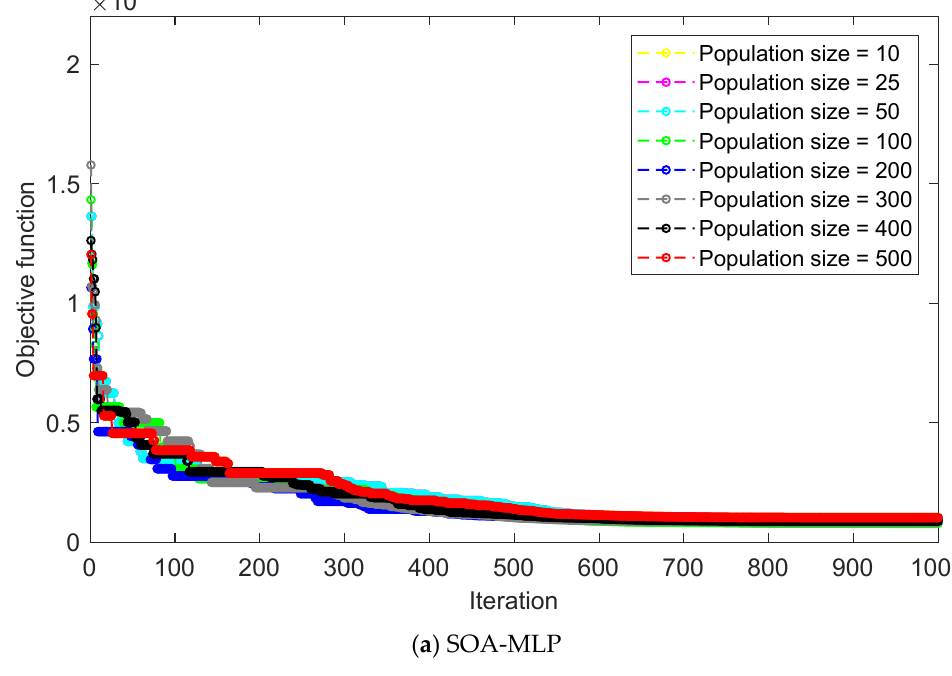
Table 1. Computed errors for different population sizes.